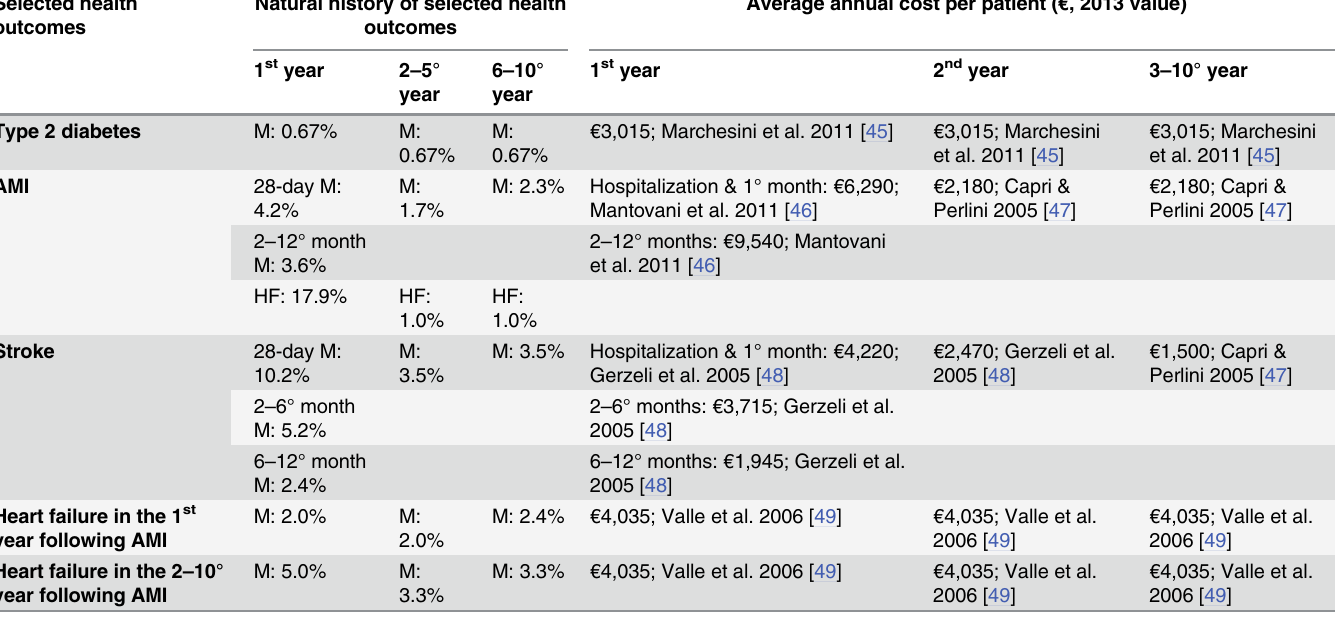
cyclists are about 1.4 times more likely than car drivers to have a fatal road traffic accident, whereas there are about 84% less road traffic deaths per minute travelled by bicycle than by motorcycle, moped or scooter. The change in absolute numbers of road traffic accidents and deaths was estimated based on the amount of minutes shifted from travel by car or motorcycle/moped/scooter to bicycle, according to the two cycling promotion scenarios (Table 6) and assuming the same travelled time for each means of transportation, similarly as done by previous studies [13,14]. In Flor- ence, due to the high percentage of regular motorcycle, moped or scooter commuters (21.4% for transfers of up to 30 minutes), in both our scenario analyses we expect a decrease both in Table 4. Health economic assessment model